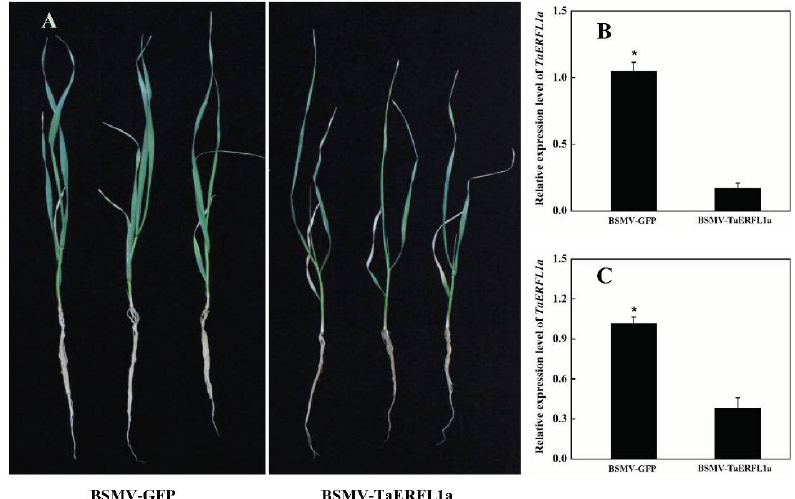
Figure 3. Phenotypes of BSMV-TaERFL1a-inoculated and BSMV-GFP-inoculated wheat seedlings suffering from 20% PEG6000 for 3 d ( A ); and transcript levels of TaERFL1a gene at this sampling timepoint ( B , C ). Transcript levels of TaERFL1a gene were measured by qPCR using Actin ( B ) and GAPDH ( C ) genes as internal control. Each value is mean ± standard deviation of three independent biological replicates. Asterisks indicate significant differences ( p < 0.05).